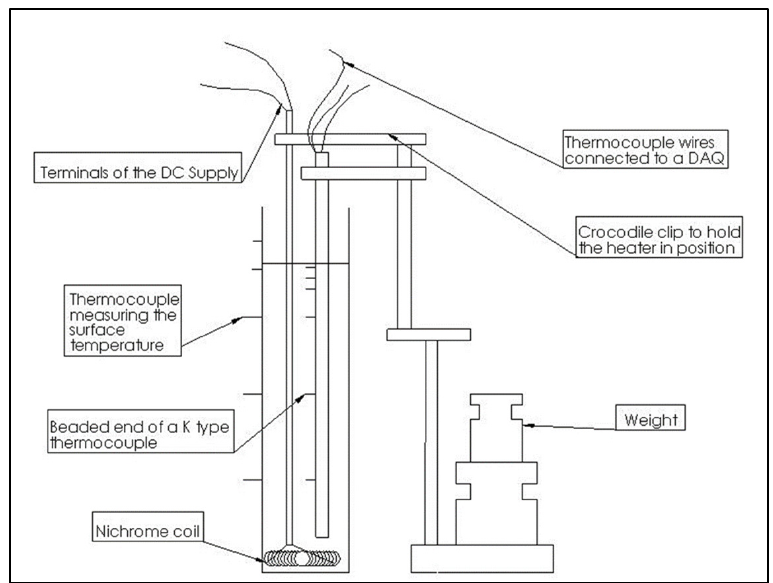
Figure 2. Schematic of the experimental apparatus used in this study.